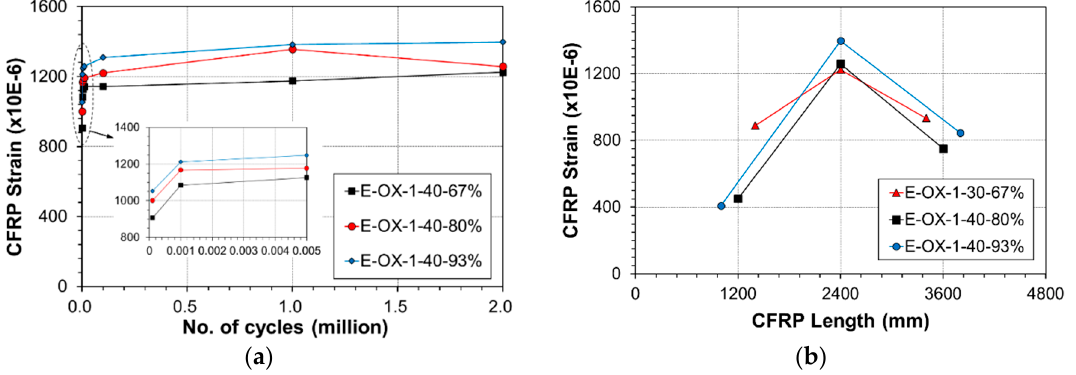
Figure 14. Variation of CFRP strain during fatigue loading at upper load limit: ( a ) mid span; ( b ) location. Table 7. Strain gauge location.